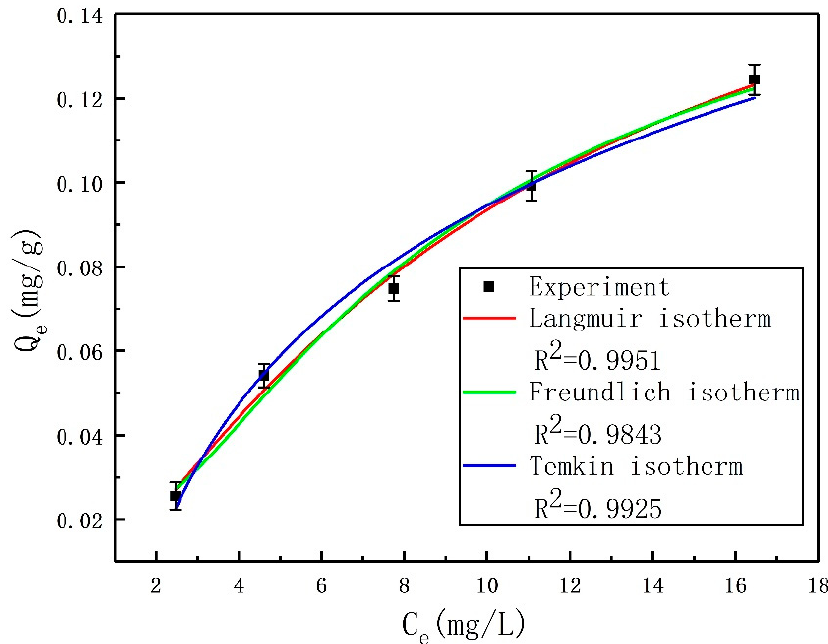
Figure 4. Langmuir, Freundlich, and Temkin isotherms for the adsorption of NH 4+ onto CB-GAC. (Experimental conditions: Initial pH: 7; CB-GAC dose: 10 g/100 mL; temperature: 25 °C; contact time: 24 h). Table 5. Parameters of isotherm models for the adsorption of NH 4+ onto CB-GAC. Model